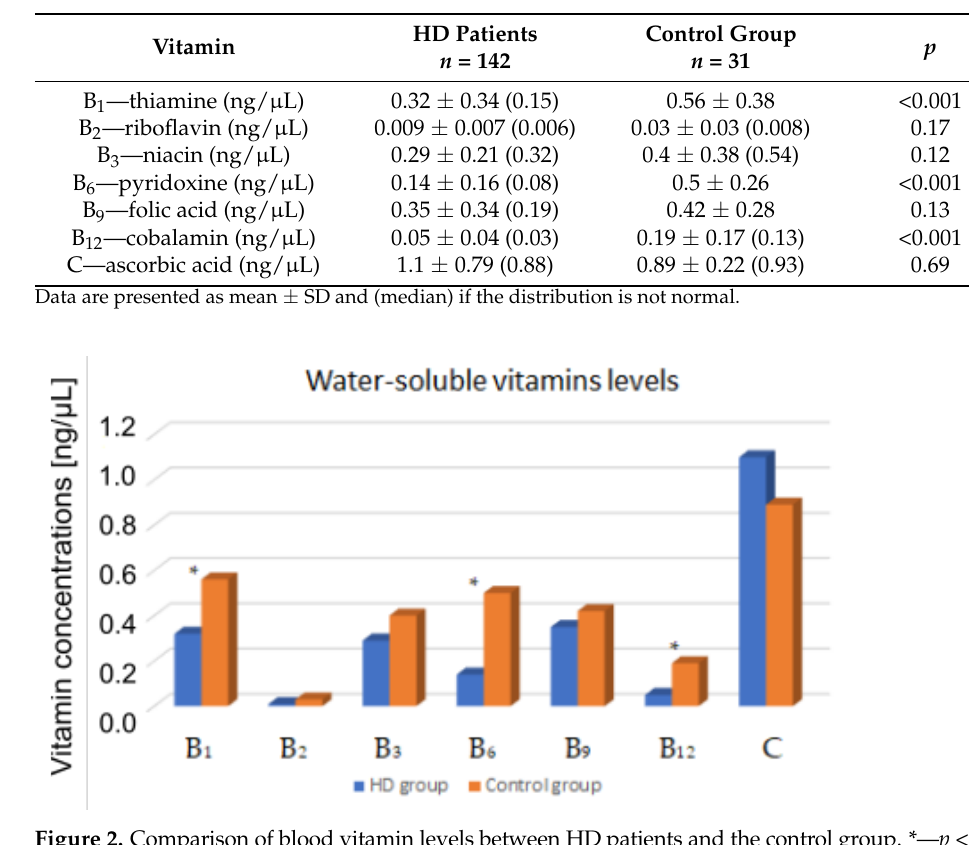
Figure 2. Comparison of blood vitamin levels between HD patients and the control group. * — p < 0.05.